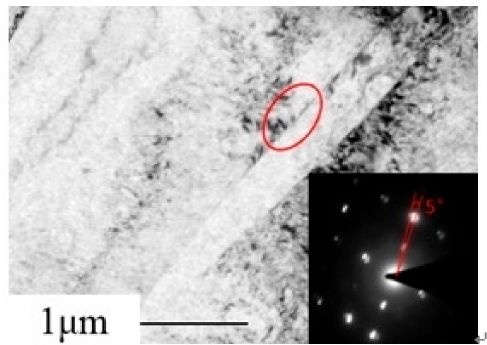
Figure 7. Transmission electron microscope image of sample